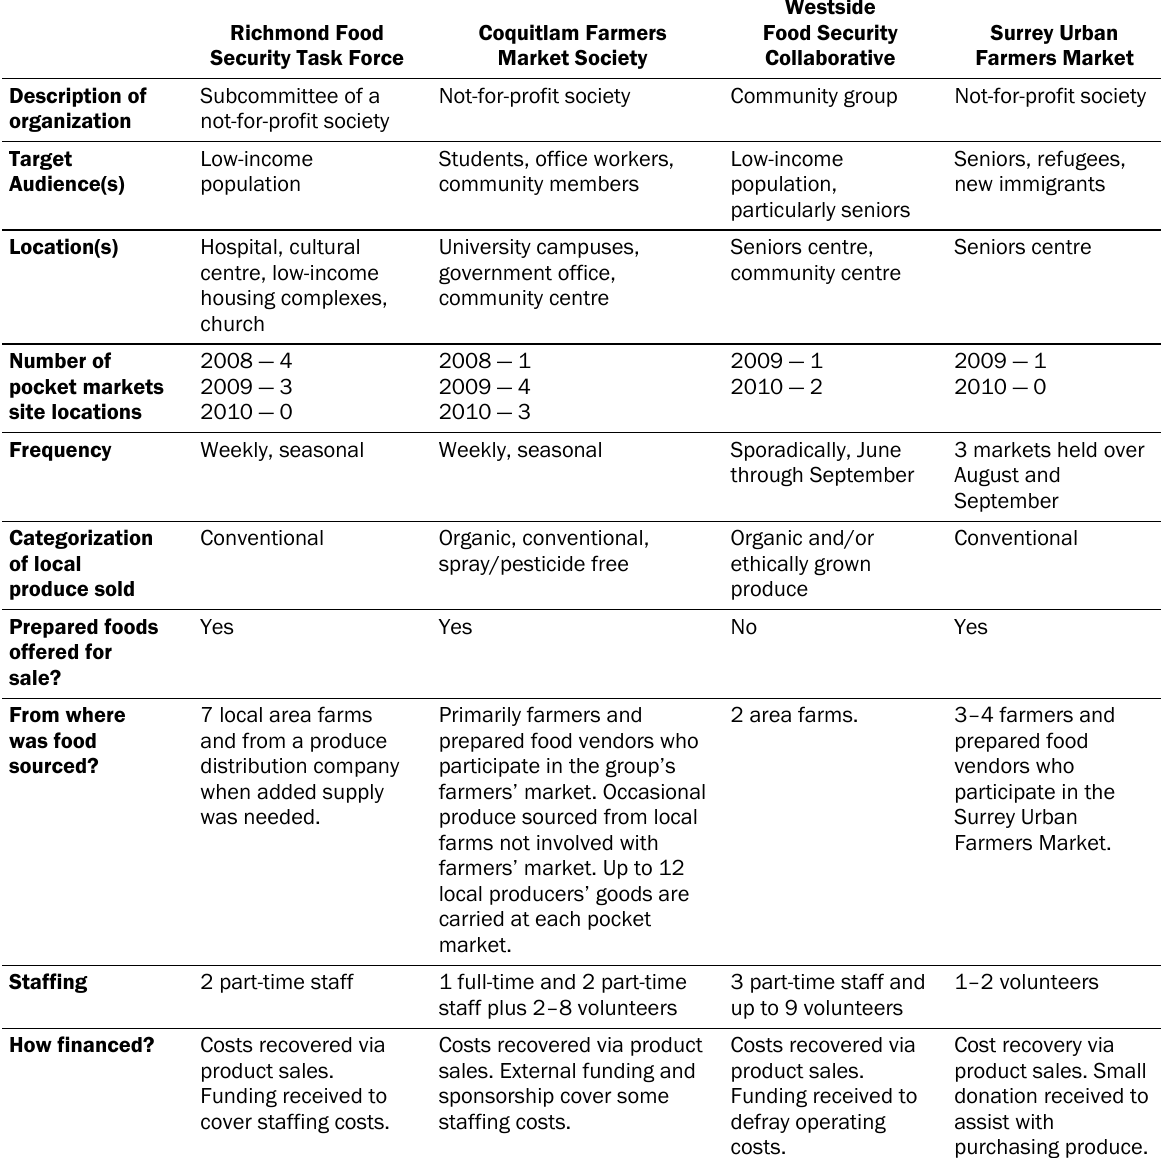
Table 1: Comparison of Pocket Markets, Metropolitan